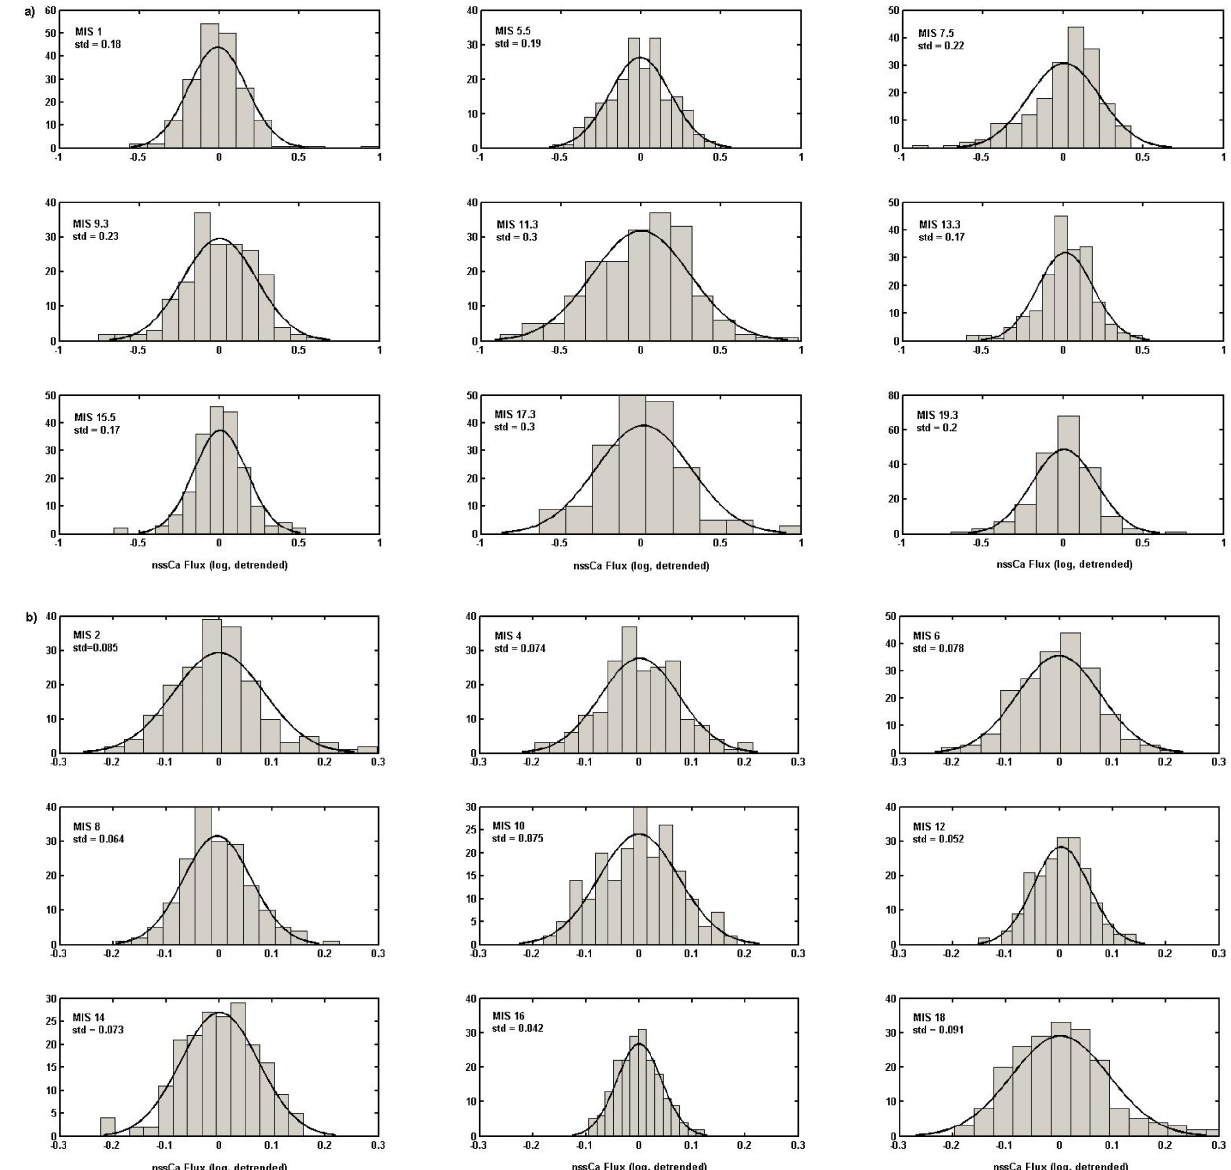
Fig. 6. Distribution during 5kyr sections of (a) interglacials and (b) glacials using detrended and logarithmised 25 year mean nssCa 2 + data. The standard deviations shown are derived from the Gaussian